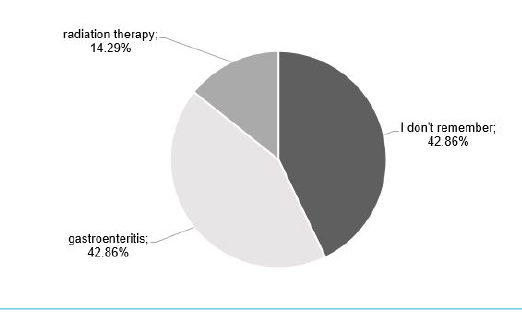
Figure 2b: Precipitating factors for the adrenal crises reported on- ly by the patients.